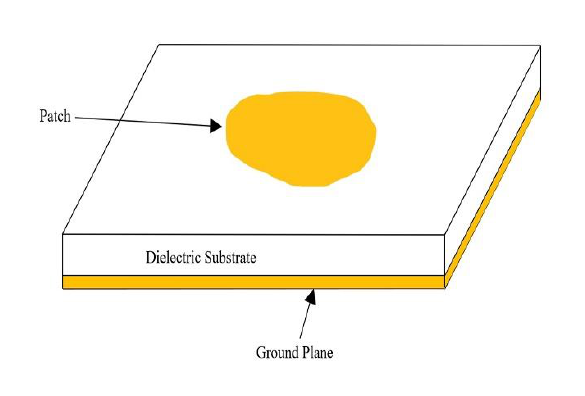
Fig. 1. Microstrip Patch Antenna